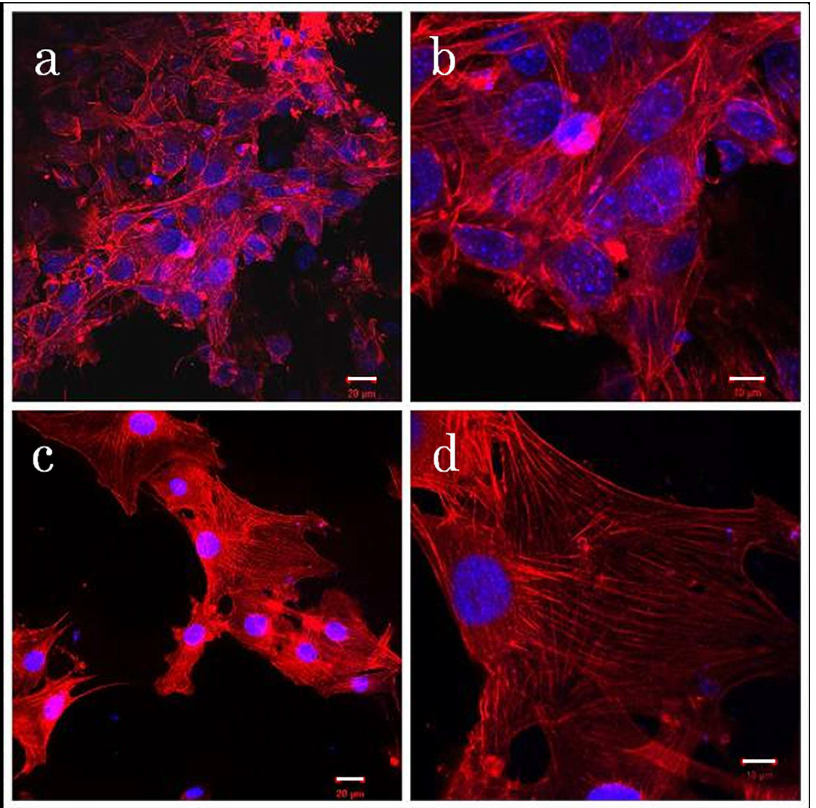
Fig 10. MC3T3-E1 cell morphology on MWCNT blocks. Fluorescence photomicrographsof cell cultures on PET-reinforced collagensheets (a,b) and MWCNT blocks (c,d). White bars: 20 μ mfor (a,c) and 10 μ mfor